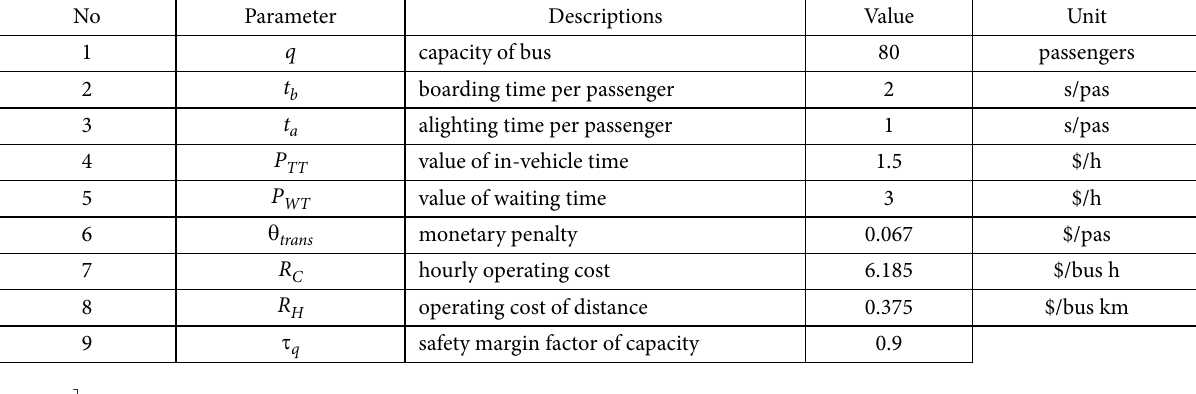
Figure 5. Passengers will not transfer in their trips when a bus fare is more than $0.17 without transfer discounts.